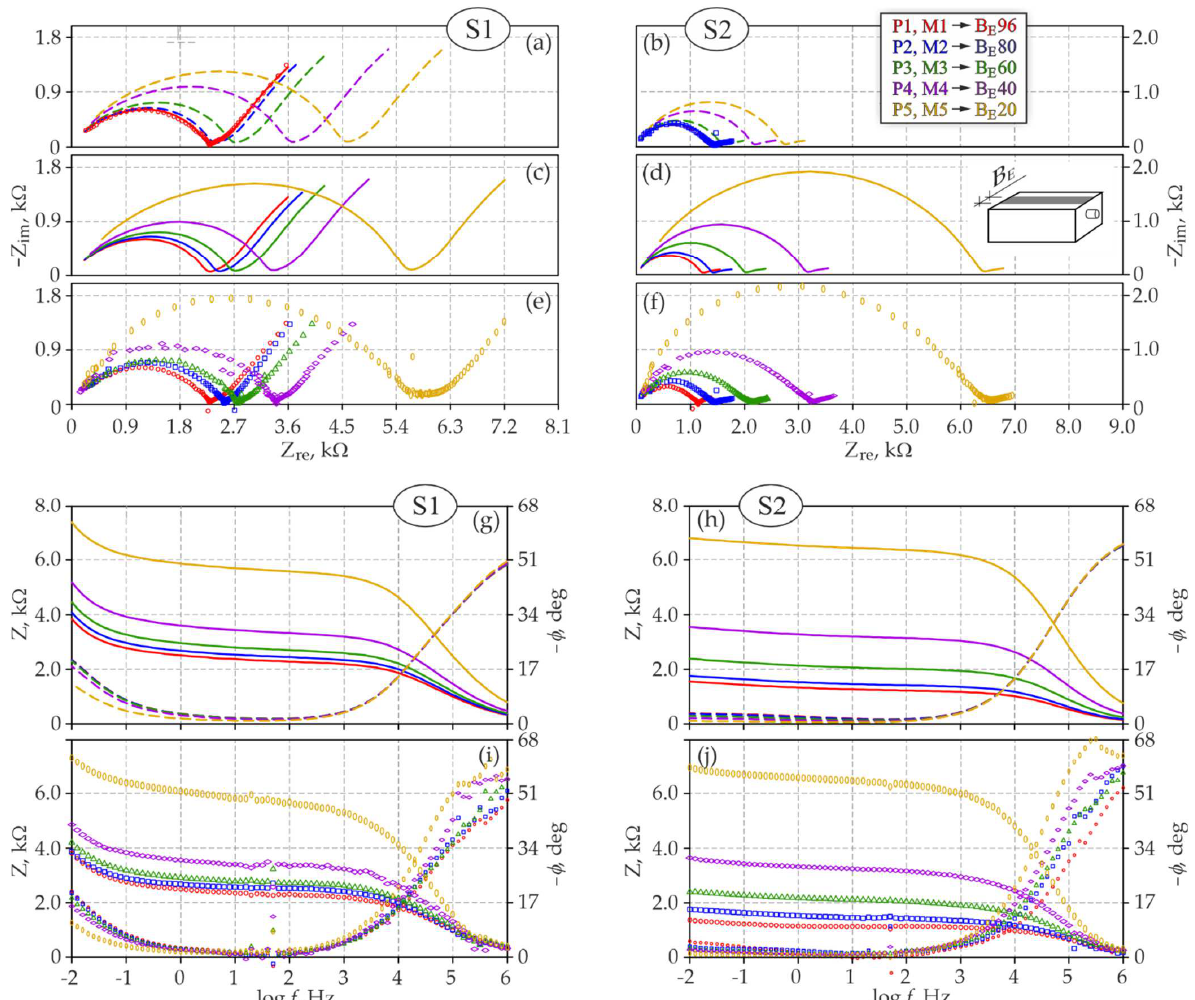
Figure 5. Comparison of test and simulation results concerning the impact of the counter electrode width on shapes of impedance spectra of steel in concrete of series S1 and S2 : ( a ) and ( b ) model spectra obtained on the Nyquist plot from initial spectra based on the 3D model , ( c ) and ( d ) adjusted model spectra on the Nyquist plot that included moisture content in concrete, ( e ) and ( f ) experi- mental spectra on the Nyquist plot, ( g ) and ( h ) model spectra on the Bode plot with an included effect of moisture content in concrete, ( i ) and ( j ) experimental spectra on the Bode plot. When comparing both groups of spectra ( S1 and S2 ) in terms of the impact of a chang- ing length (cid:2) (cid:3) from analysing Figure 4B was over a five-fold difference in the scale of both components